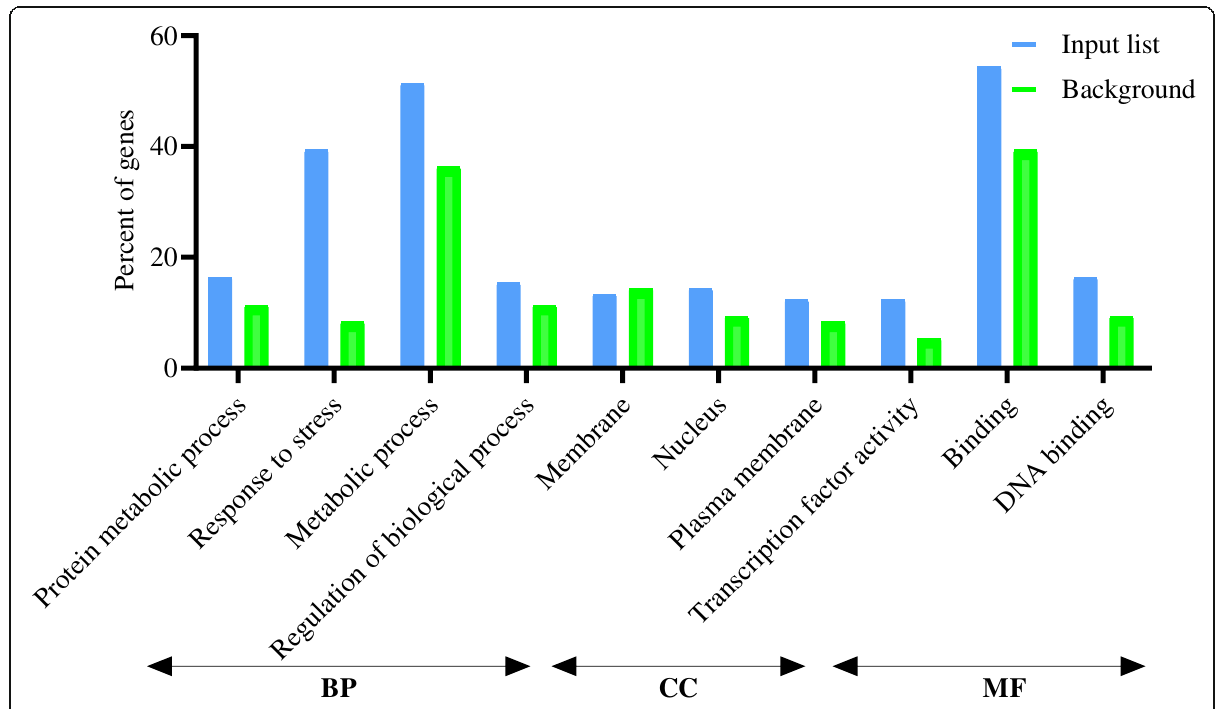
Fig. 3 Gene Ontology enrichment analysis (BP, biological processes; CC, cellular components; and MF, molecular function) of differentially expressed genes ( ≤ 5 and ≥ − 5) at drought stress conditions in reproductive stage barley based on microarray data using